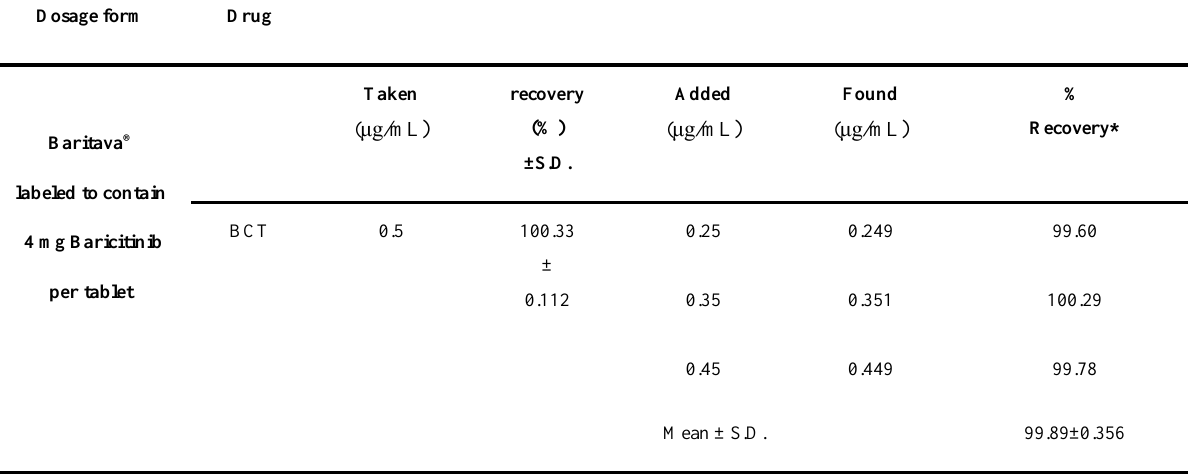
Table 3. Determination of BCT in its formulation by the proposed spectrofluorometric method